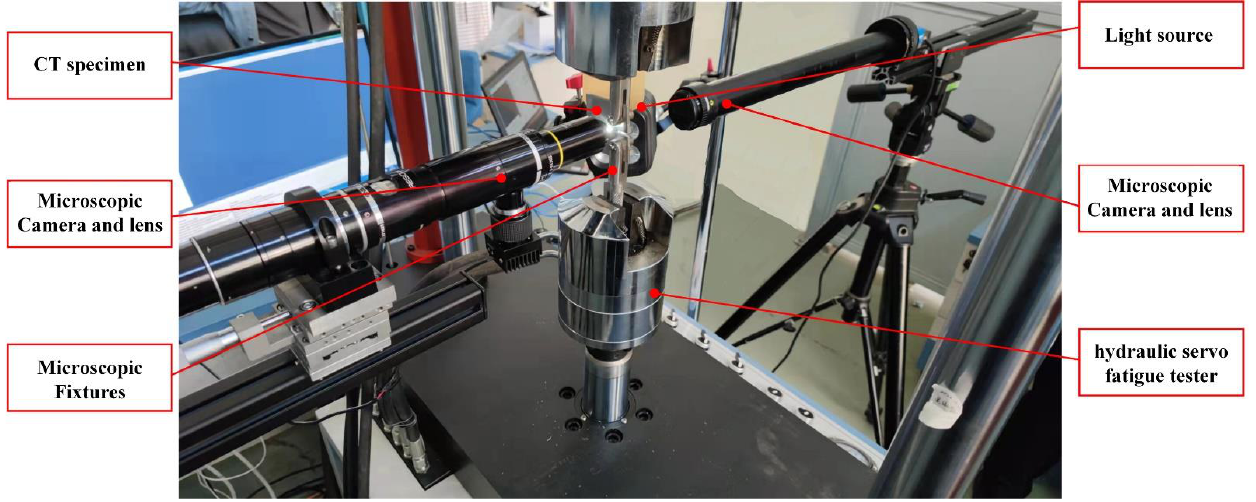
Figure 4. Labeled photo of the experimental platform.